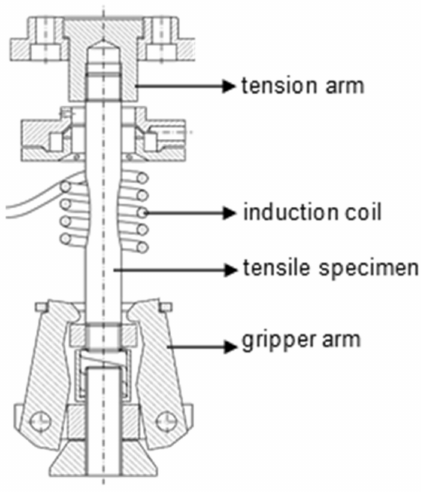
Figure 2. Schematic thermomechanical simulator.